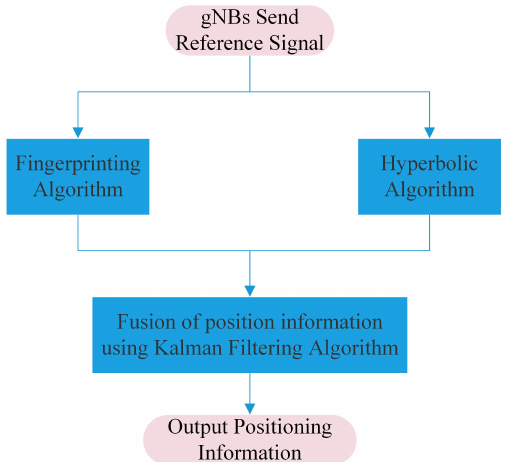
Figure 1. Schematic diagram of the main steps of the